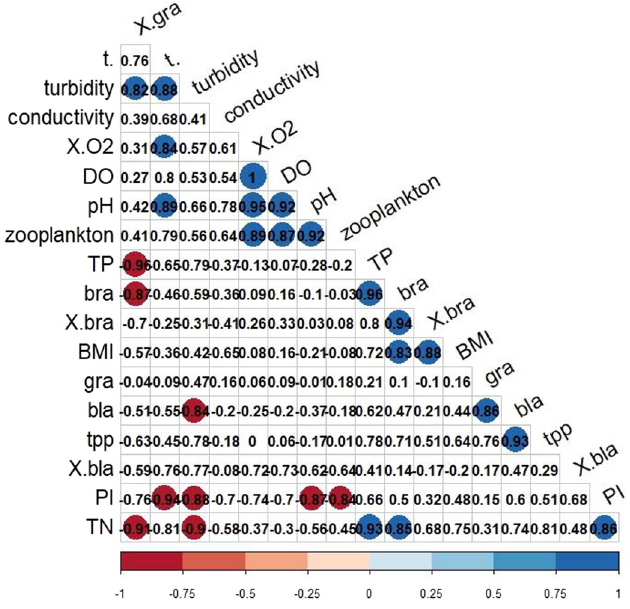
Fig. 3. Production of fi sh biomass by species and fi shpond in the coupled, semi-intensive, and extensive treatments within each replicate (1 and